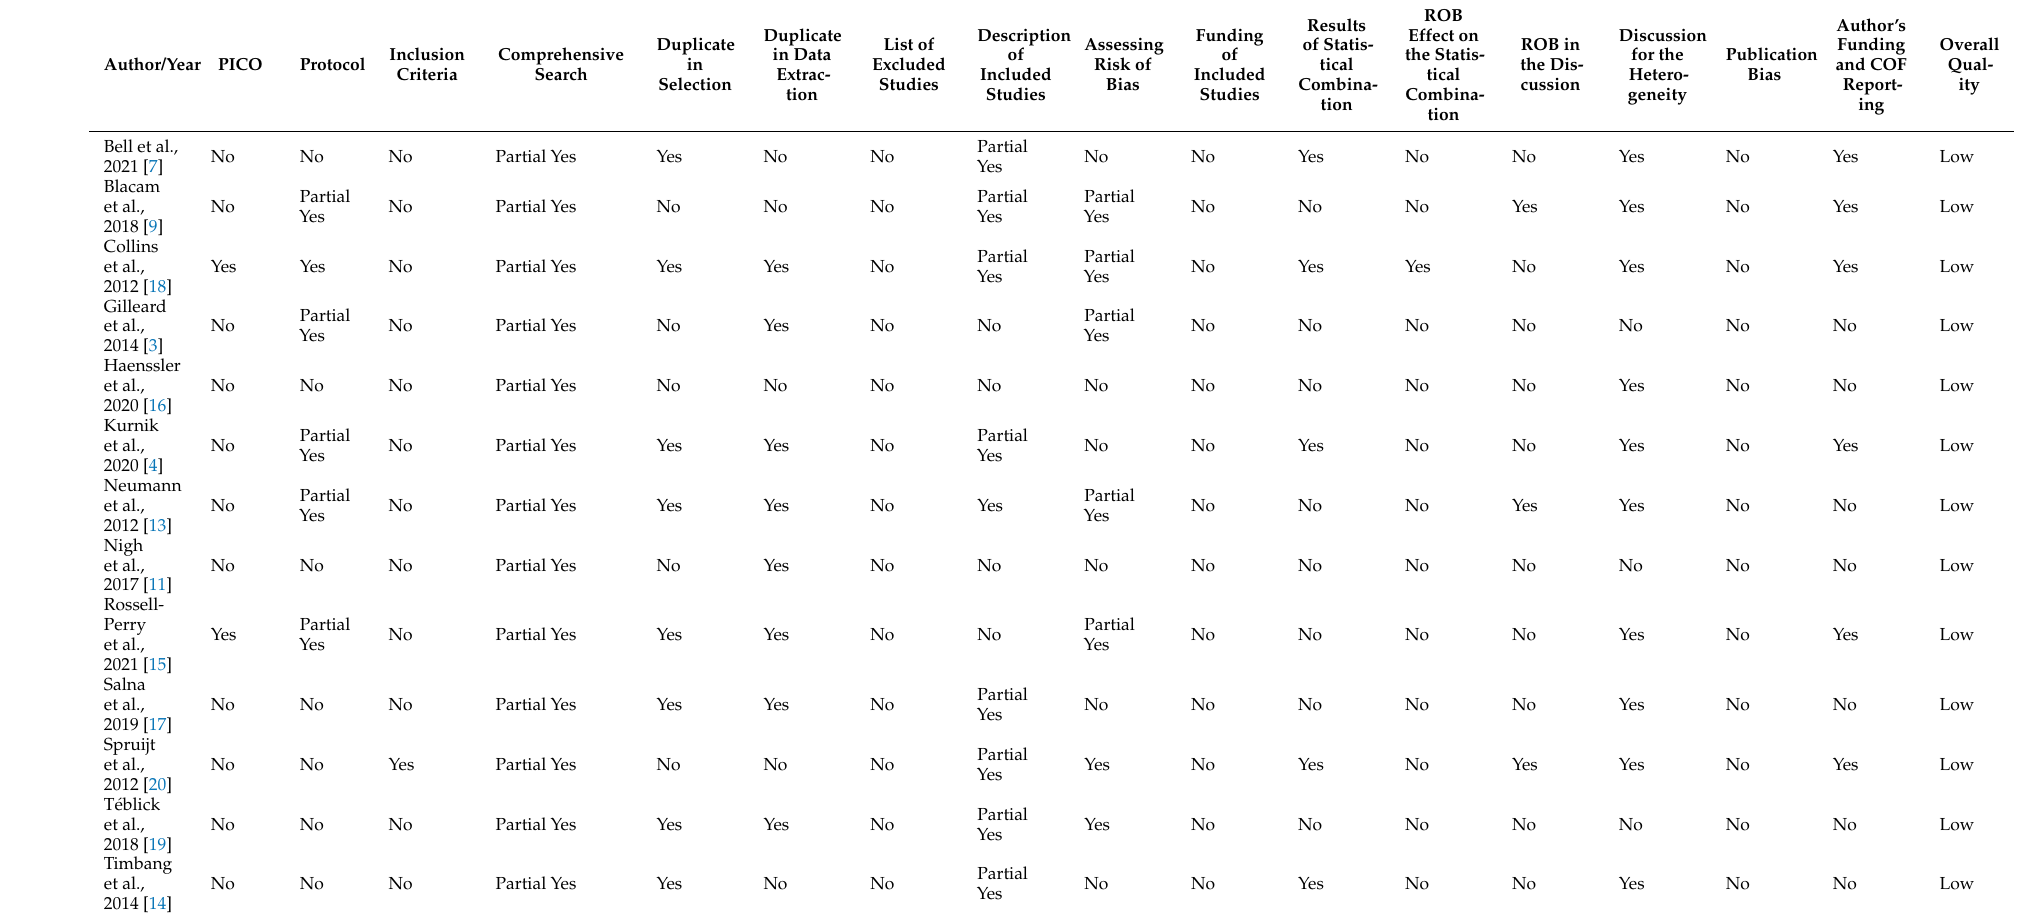
Table 5. Quality assessment of the included reviews, using the AMSTAR2